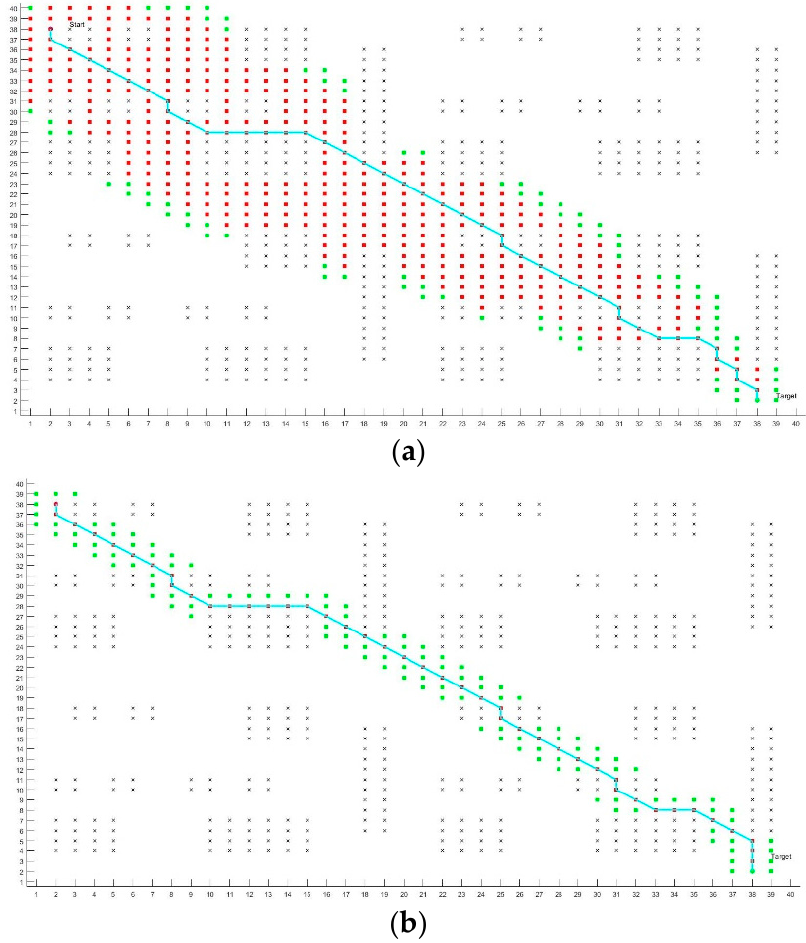
Figure 10. Comparison of global path planning for complex map environments. ( a ) Traditional A-star algorithm; ( b ) optimization of the A-star algorithm.